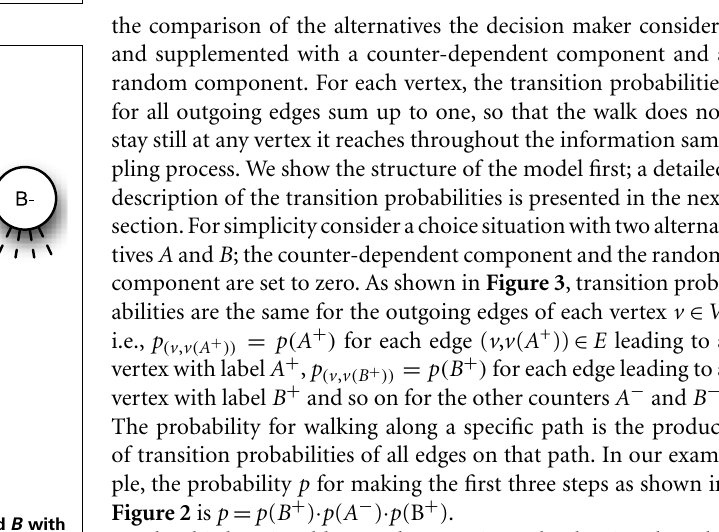
FIGURE 2 | 4-ary tree for choice between two alternatives A and B with highlighted sample path r → B + → A − → B + → ...